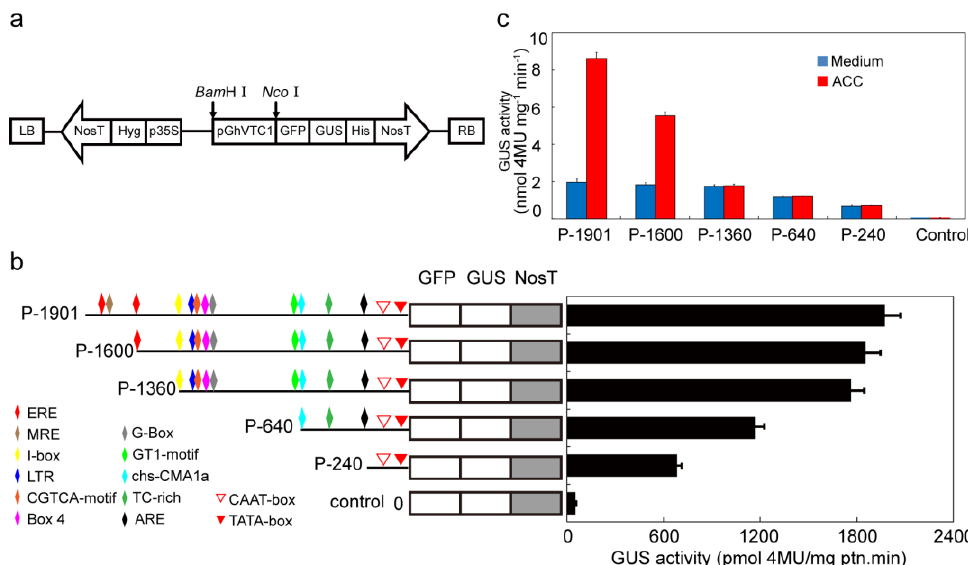
Figure 7. Promoter activity analysis of the 5 ’ -truncted PGhVTC1 . ( a ) Schematic presentation of the 5 ’ -truncted constructs. The full-length and 5 ’ -truncated fragments of PGhVTC1 were constructed into the modified pCAMBIA1304-GFP-GU S vector using the various 5 ’ -truncted PGhVTC1 to replace the CaMV35S promoter to drive the expression of the GFP-GUS gene, generating the constructs P-1901, P-1600, P-1360, P-640, and P-240. The constructed 5 ’ -truncted PGhVTC1 vectors were transformed into tobacco leaves using the Agrobacterium -mediated transient transformation method. ( b ) Quantitative analysis of the GUS activity of different 5 ’ -truncted PGhVTC1 . The GUS activity was measured in transgenic tobacco leaves transformed with the different 5 ’ -truncted PGhVTC1 constructs. The GUS activity was defined as pmol 4-MU per mg protein per min. The data are presented as the average of three independent experiments. The colored different symbols represent the cis -acting elements distributing on the GhVTC1 promoter regions at the corresponding sites. ( c ) Promoter activity analysis of 5 ’ -truncted PGhVTC1 constructs under ACC treatment. The various 5 ’ -truncted PGhVTC1 transgenic tobacco leaves were treated with or without 10 µmol of ACC. Then, the GUS activity was determined by the fluorescence spectrophotometer. The GUS activity of non-DNA transformants (control) was also investigated. Each value represents the mean of the results from three independent experiments, and the bars indicate standard deviations.